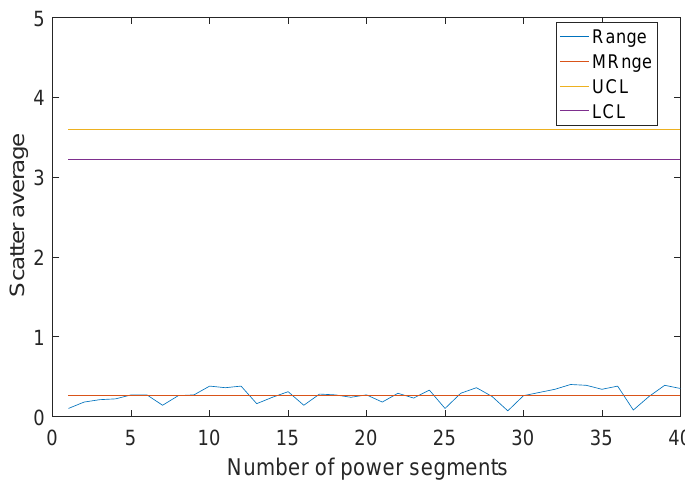
Figure 4. Horizontal comparison control chart of four turbines.